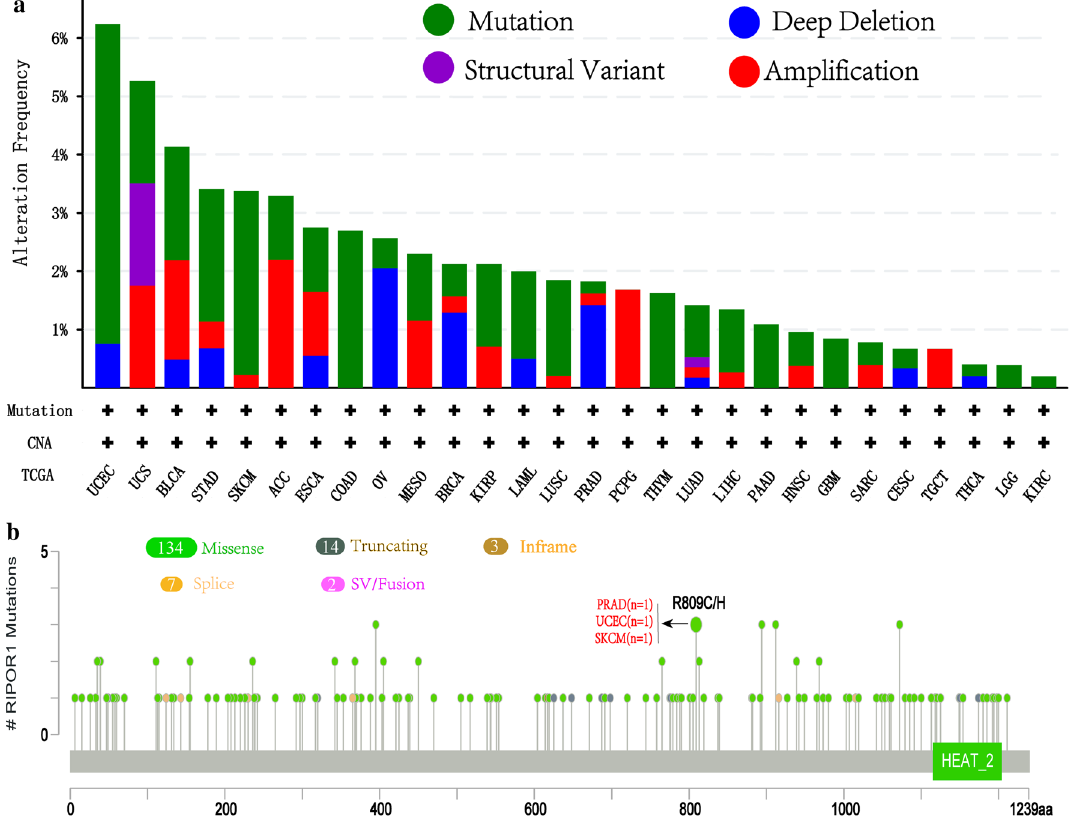
Fig. 3 Mutation feature of FAM65A in different tumors of TCGA dataset. The alteration frequency with mutation type ( a ) and mutation site ( b ) are